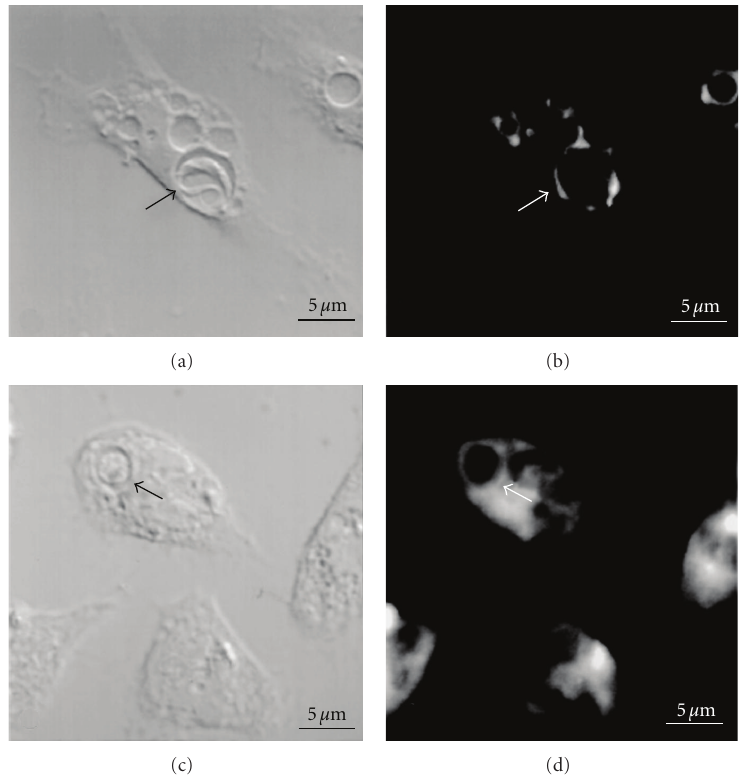
Figure 6: (a, b) DTAF (sialic acid marker) labeled macrophages were incubated with trypomastigote forms of Trypanosoma cruzi for 1hr at 37 ◦ C. Observation by confocal laser scanning microscope (CLSM): DIC image (a) and corresponding fluorescence (b) images. Observe the labeling of the membrane lining the parasitophorous vacuole containing a trypomastigote form (arrow); (c, d) macrophages labeled with PKH-26 (lipid marker) were allowed to interact with trypomastigote forms of T. cruzi for 1hr at 37 ◦ C. Observation by CLSM: DIC (c) and corresponding fluorescence images. Observe labeling of the plasma membrane in the parasitophorous membrane containing a trypomastigote form (arrow). Bar: 5 μ m (after